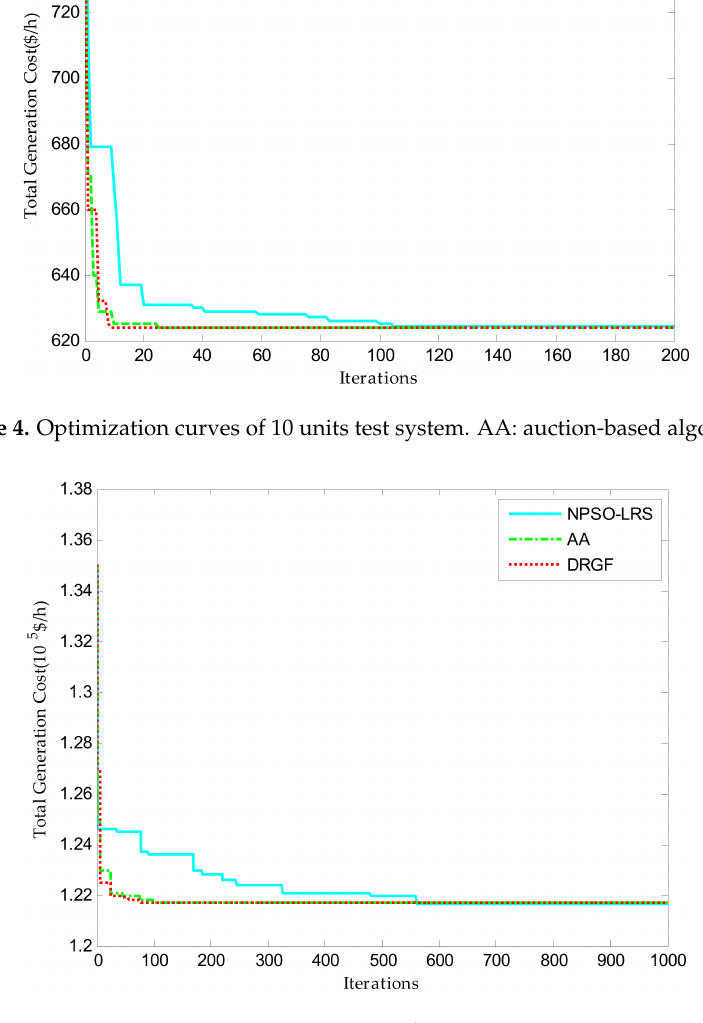
Figure 5. Optimization curves of 40 units test system. Table 1. Optimization results of six units test system. PSO-LRS: particle swarm optimization-simple local random search; NPSO: new particle swarm optimization; NPSO-LRS: new particle swarm optimization- simple local random search. DRGF: distributed randomized gradient-free